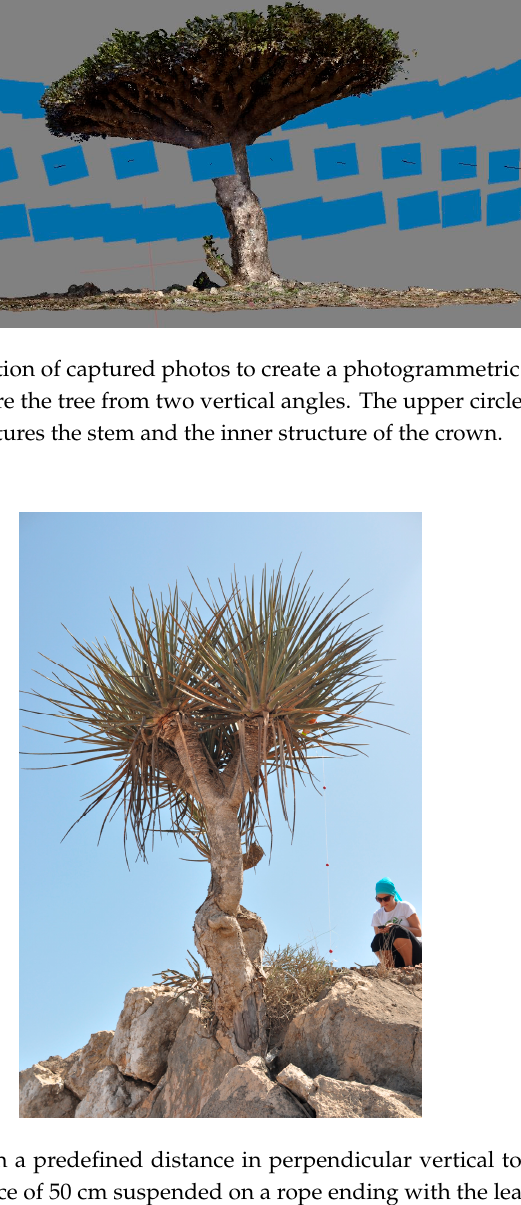
Figure 3. Prism points with a predefined distance in perpendicular vertical to the Earth’s surface. Beads with a mutual distance of 50 cm suspended on a rope ending with the lead are used to define dimensions in the resulting 3D tree point cloud.